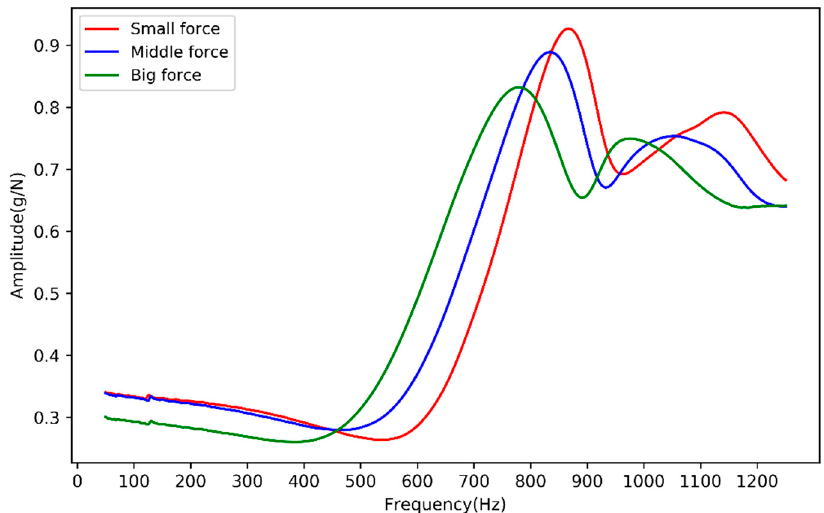
Figure 6. The frequency response curve of prismatic cells at same point with di ff erent knocking force.